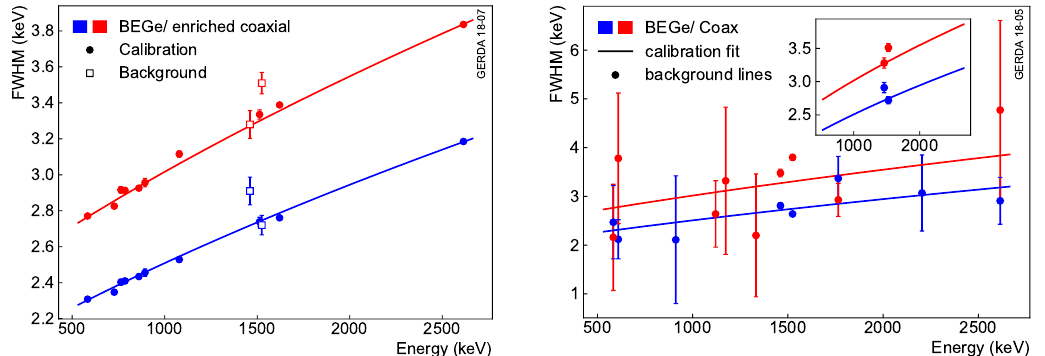
Figure 3. The energy resolution in Phase II as a function of the energy for both the BEG E and C OAX detectors. ( Left ): The exposure-weighted FWHM of the γ lines adopted in the calibration vs. energy, and their fit function. The FWHM of the 42 K and 40 K lines in the physics data are superimposed; ( Right ): the FWHM of the gamma lines in the physics data, and, superimposed, the exposure-weighted FWHM function derived from the calibrations: the inset presents the exposure-weighted FWHM of the two most prominent 42 K and 40 K